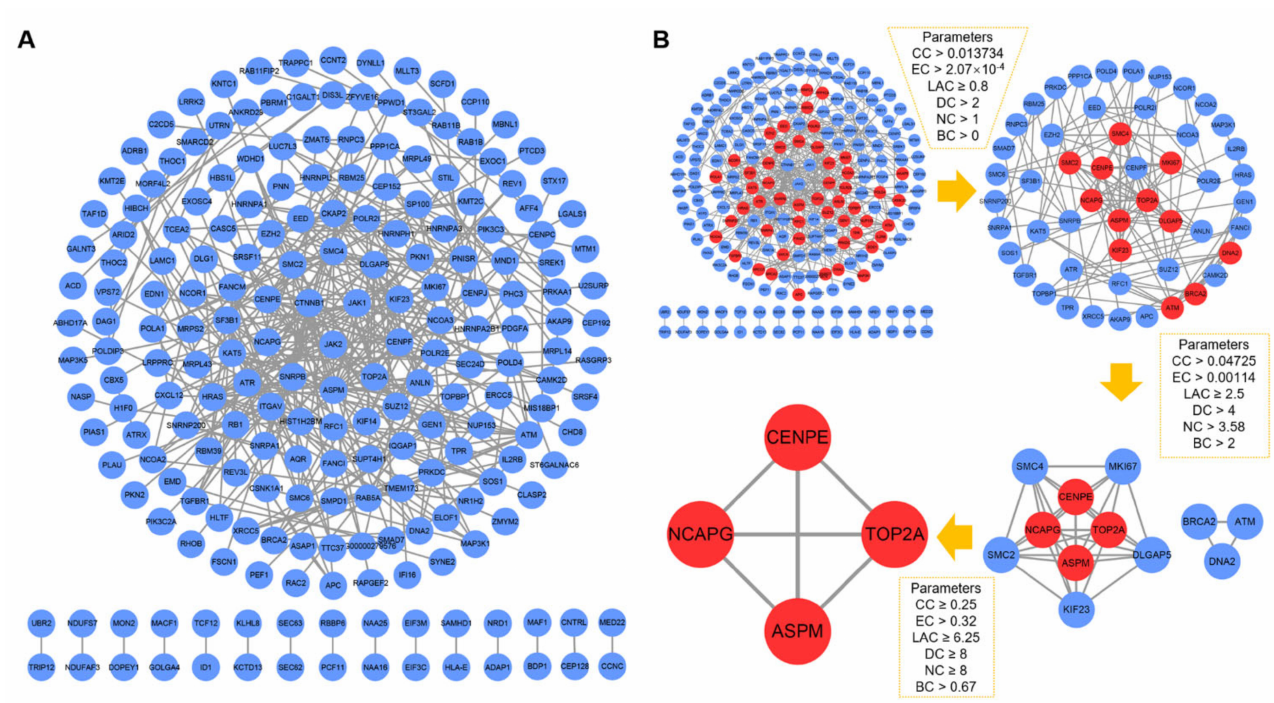
Figure 3. Establishment of the PPI network and identification of the central genes. ( A ) PPI network generated with the highest confidence score (0.900) on the STRING database. ( B ) CytoNCA plugin screened for central node genes. The red nodes represent the crucial targets of the entire network. PPI: protein–protein